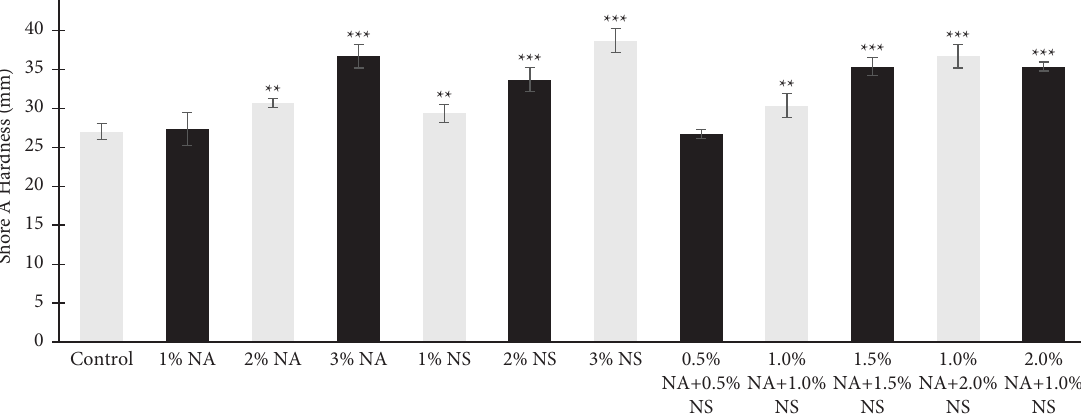
Figure 1: Shore A hardness for diferent wt. % of nanoalumina (NA), nanosilica (NS), and hybrid nanoparticle HySA. ∗∗ P < 0 . 01, ∗∗∗ P < 0 . 001.